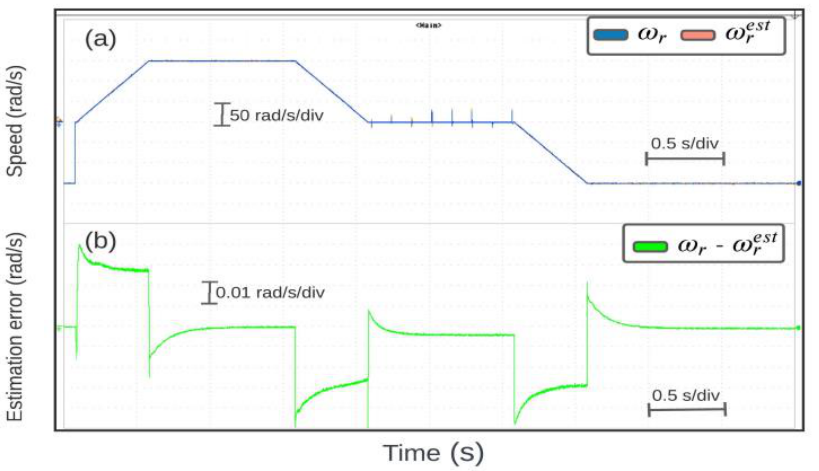
Figure 9. OeW-5PIM performance under during high-speed reverse ( a ) speeds responses; ( b ) estimation error.